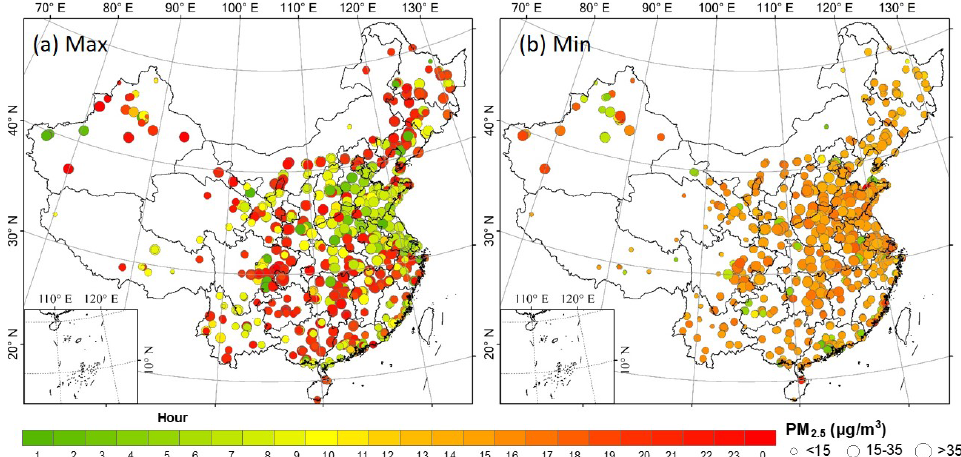
Figure 2. Spatial distribution of diurnal PM 2 . 5 averaged over the 2019 period according to the (a) maximum and (b) minimum mean PM 2 . 5 concentration over 24h. The solid color and the size of the circle denote the hour with the maximum and minimum diurnal mean concentration and the corresponding concentration value over each monitoring station,